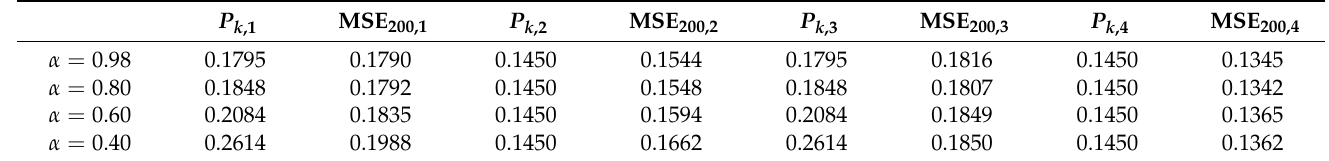
Table 2. The error covariance of the steady-state ET-KF algorithm and MSE i